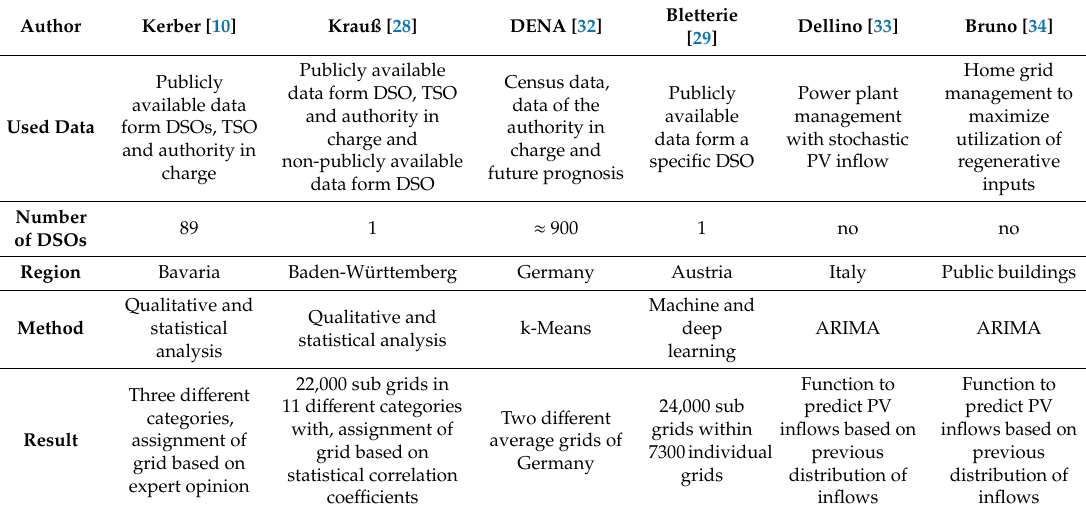
Table 1. Summary of previous empirical